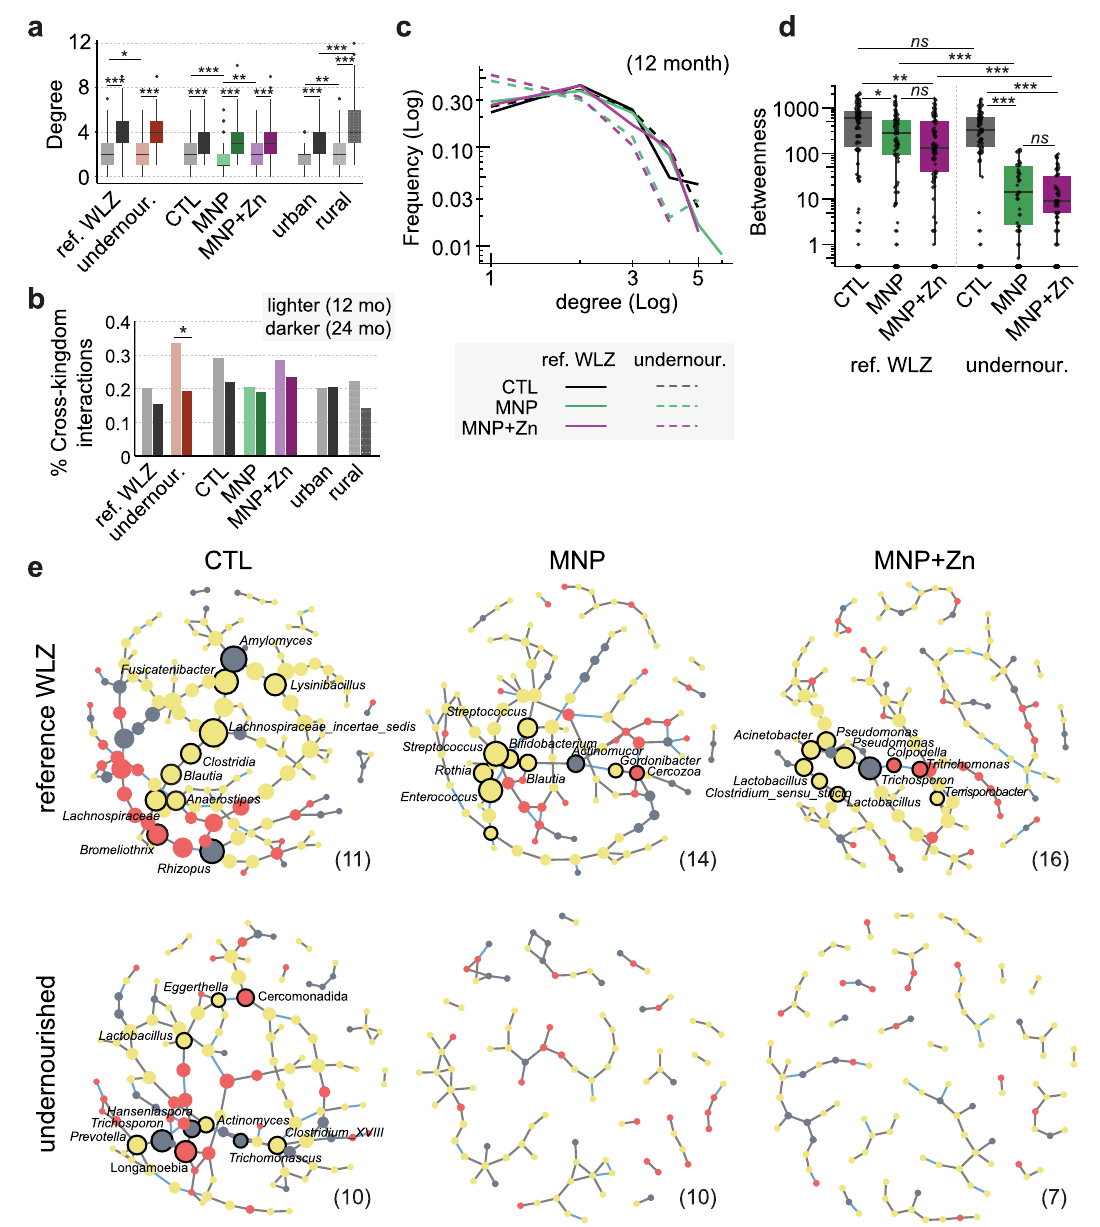
Fig. 4 Supplementation in fl uences microbial interactions. a Density of microbial interactions at 12 and 24 months of age, calculated as the number of signi fi cant associations (node degrees) each microbe has with other taxa within a sample group. Samples were grouped by age and nutritional status, supplementation arm, or place of residence (site). Lighter and darker hues represent data from 12 ( n = 68) and 24-month-old children ( n = 71), respectively. P -values are provided in Supplementary Data 3. b Proportions of signi fi cant microbial interactions occurring cross-kingdom at 12 and 24 months of age, within indicated sample groups (12 months n = 68; 24 months n = 71; undernourished 12 mo. vs. 24 mo. p = 0.021). c Degree distribution and d betweenness centrality scores of microbial networks in 12-month-old children grouped by nutritional status and supplementation arm ( n = 68; nutritional status (ref.WLZ vs undernourished) in MNP p = 9.8e-9 or MNP + Zn p = 2.2e-9; supplementation (CTL vs MNP) in ref.WLZ p = 0.033 or undernourished p = 5.6e-10, and (CTL vs MNP + Zn) in ref WLZ p = 0.0027 or undernourished p = 4.2e-11). e Graphic representations of networks representing signi fi cant microbial interactions in 12-month-old children, grouped by nutritional status and micronutrient treatment. Nodes represent bacterial OTUs (yellow) and protozoan and fungal genera (red and gray, respectively), scaled by betweenness centrality scores; node borders denote taxa with the ten highest scores. Edges represent signi fi cant positive (gray) and negative (blue) correlations among microbiota. Taxa with no predicted interactions have been removed. The numbers of samples used to generate each network are indicated within brackets. Boxplots in a and d represent medians and interquartile ranges (IQR), and whiskers demarcate 1.5 × IQR. Statistical differences were determined using a two-sided Wilcoxon rank-sum test in ( a and d ) or a two-sided Fisher ’ s Exact test in ( b ) and corrected for multiple testing using the Benjamini – Hochberg procedure. Signi fi cance * p < 0.05, ** p < 0.01, *** p < 0.001, ns not signi fi cant.